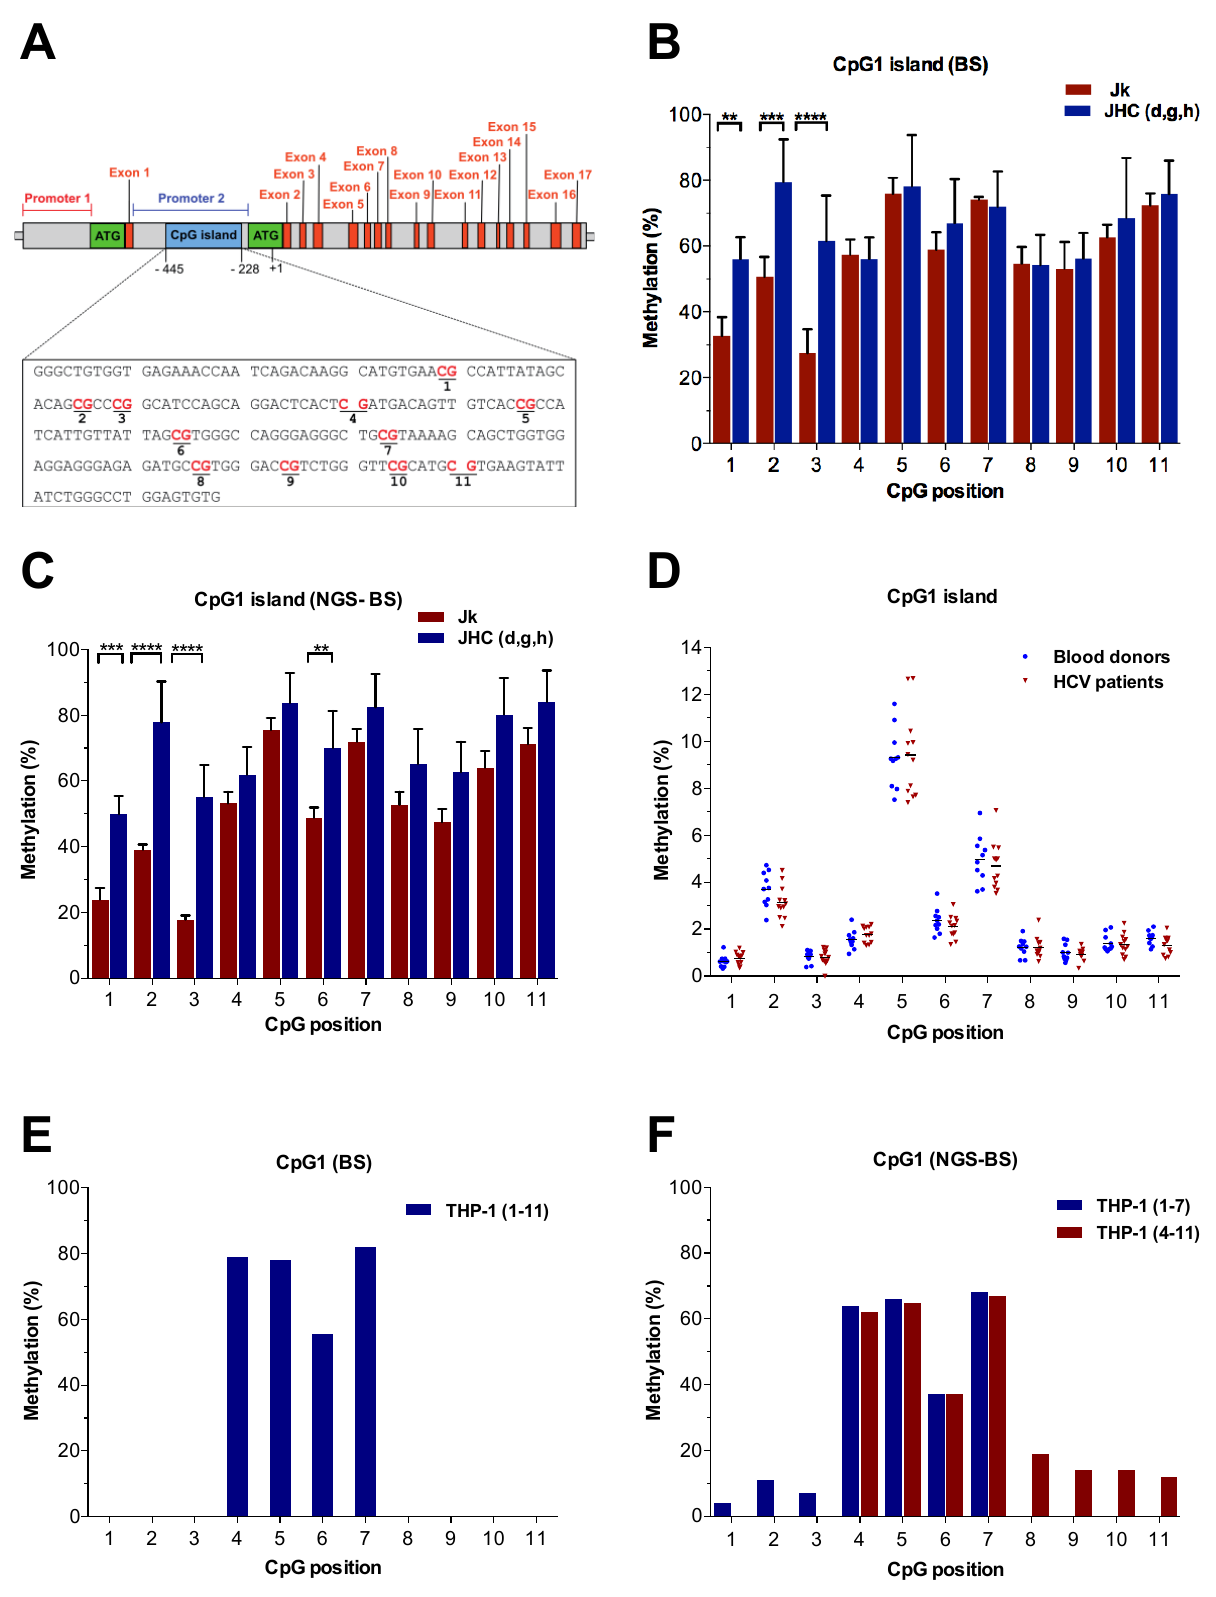
Figure 3. Quantitative CpG methylation pattern on SHP-1 P2 with NGS-BS. ( A ) The SHP-1 gene consisting of 17 exons and two cell-specific promoters, promoter 1 (P1, red horizontal line) and pro- moter 2 (P2, blue horizontal line). The translation start codons (ATG) for encoded transcripts origi- nating from the P1 and P2 are indicated. The CpG-rich region called CpG island 1 (CpG1, -445 to -